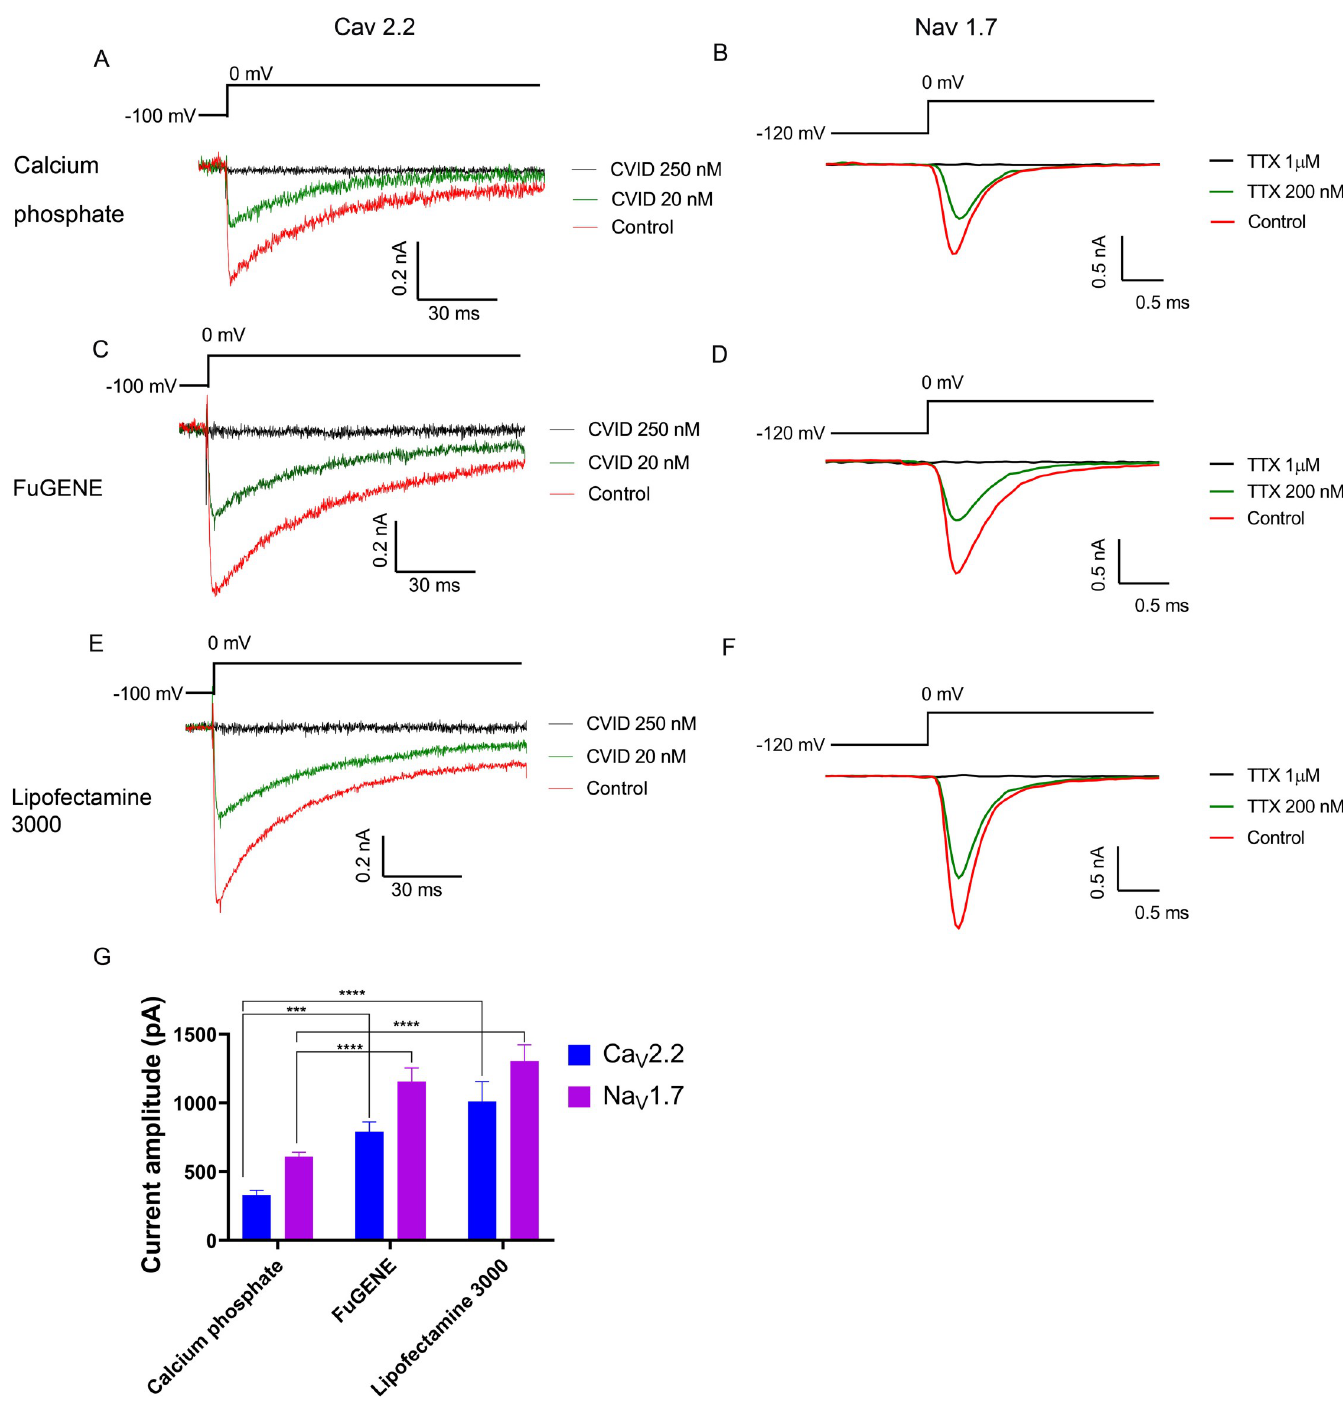
Fig 7. Calcium current measured with a QPatch. Representative I Ca during 120 ms depolarization to V max (0 mV) from a holding potential of –100 mV before and after perfusion of 20 nM and 250 nM CVID obtained from HEK 293T cells transfected by (A) calcium phosphate, (C) FuGENE or (E) Lipofectamine 3000. Representative I Na during 20 ms depolarization to V max (0 mV) from a holding potential of –80 mV and pre-pulse of –120 mV before and after perfusion of 200 nM and 1 μ M TTX obtained from HEK 293T cells transfected by (B) calcium phosphate, (D) FuGENE or (F) Lipofectamine 3000. The current amplitude of both FuGENE-, and Lipofectamine 3000-mediated transfection methods was significantly higher compared to calcium phosphate-mediated transfection for both Ca V 2.2 and Na V 1.7 channels (G). Data are presented as mean ± SEM, from N = 3 independent experiments, each testing 2–6 cells, ��� and ���� denotes P < 0.001 and P < 0.0001,